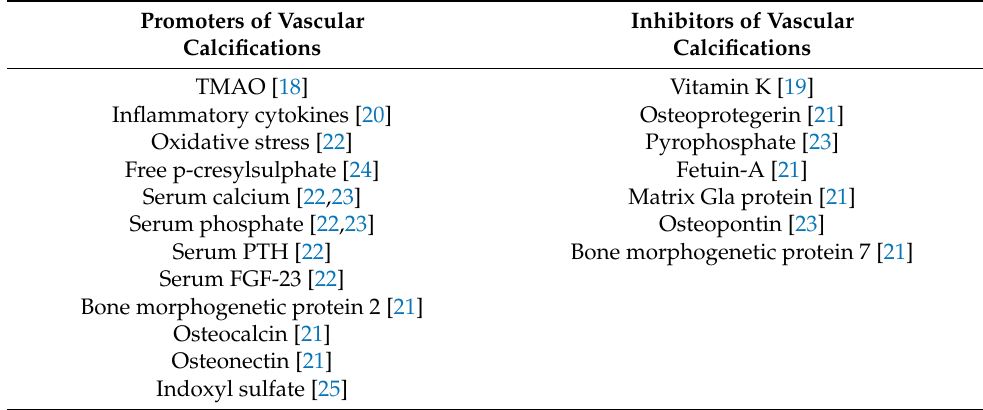
Table 1. Influence on vascular calcifications in patients with chronic kidney disease and gut